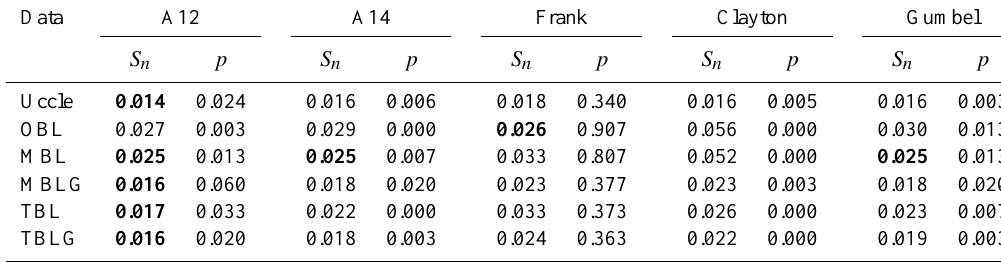
Table 10. S n and p values for D and S for different copulas. The best fit is indicated in bold.